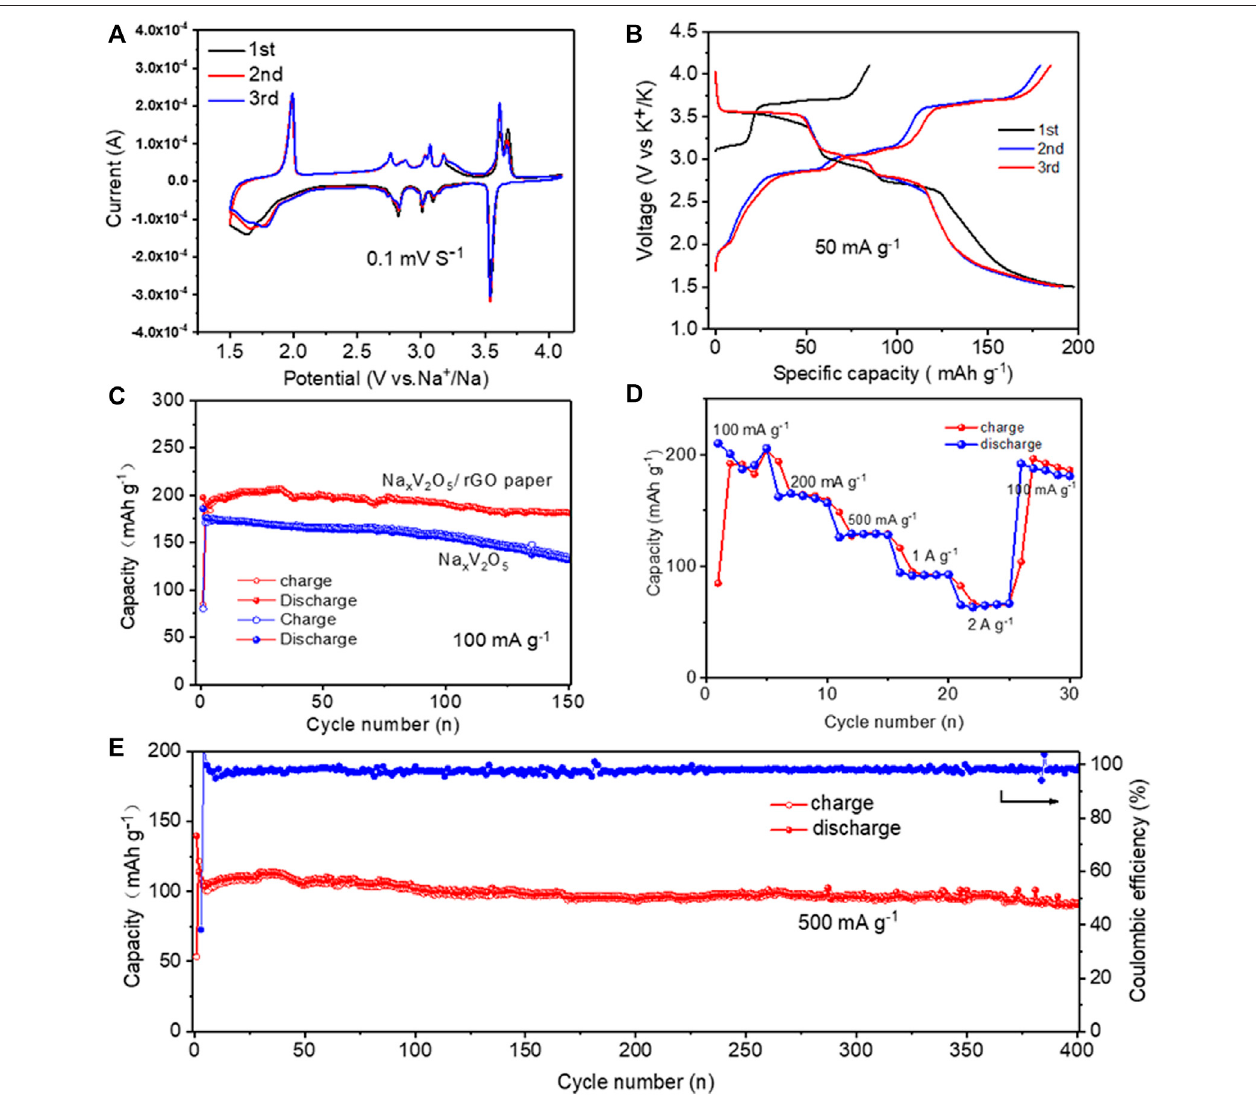
FIGURE4|(A) TheinitialthreeCV curves oftheNa x V 2 O 5 /rGOelectrodeat ascanningrateof0.1 mV s − 1 ; (B) Initialthreecharge/dischargecurves oftheNa x V 2 O 5 / rGO electrode at a current density of 100 mA g − 1 . The electrochemical performance of Na x V 2 O 5 /rGO electrode: (C) cycling performance; and (D) rate capability. (E) Cycling performance of Na x V 2 O 5 /rGO electrode at a current density of 500 mAg − 1 .